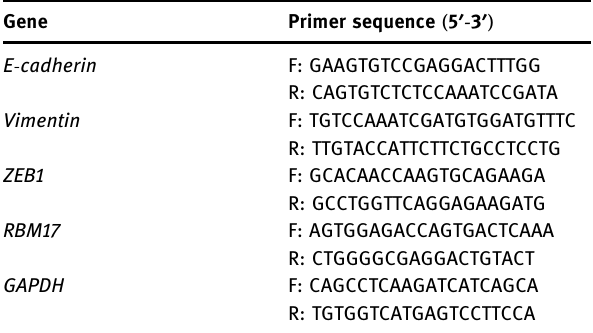
Table 1: Primer sequences used for qRT - PCR